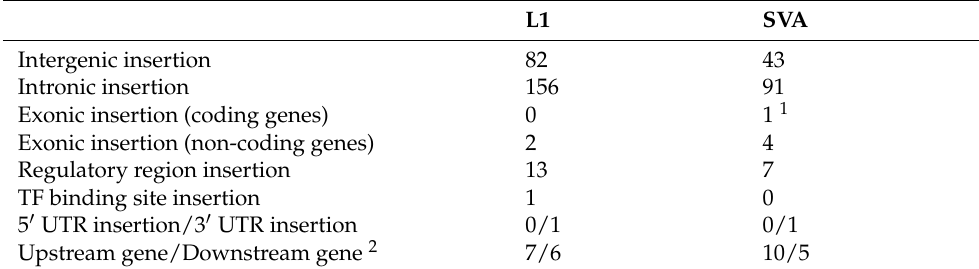
Table 6. Insertional location of retroelements carrying 3 (cid:48) transductions.